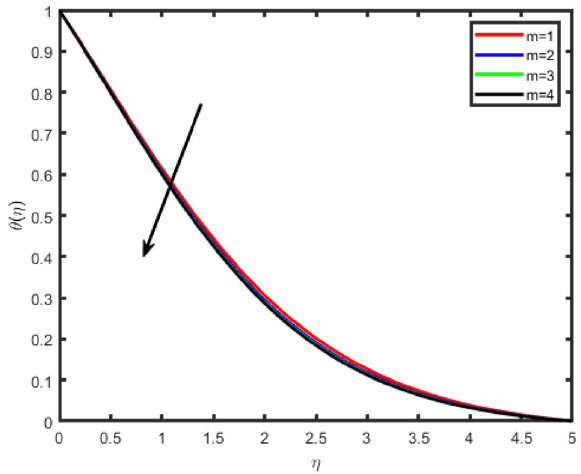
Figure 8. Effect of Hall parameter (m) on temperature θ(η).